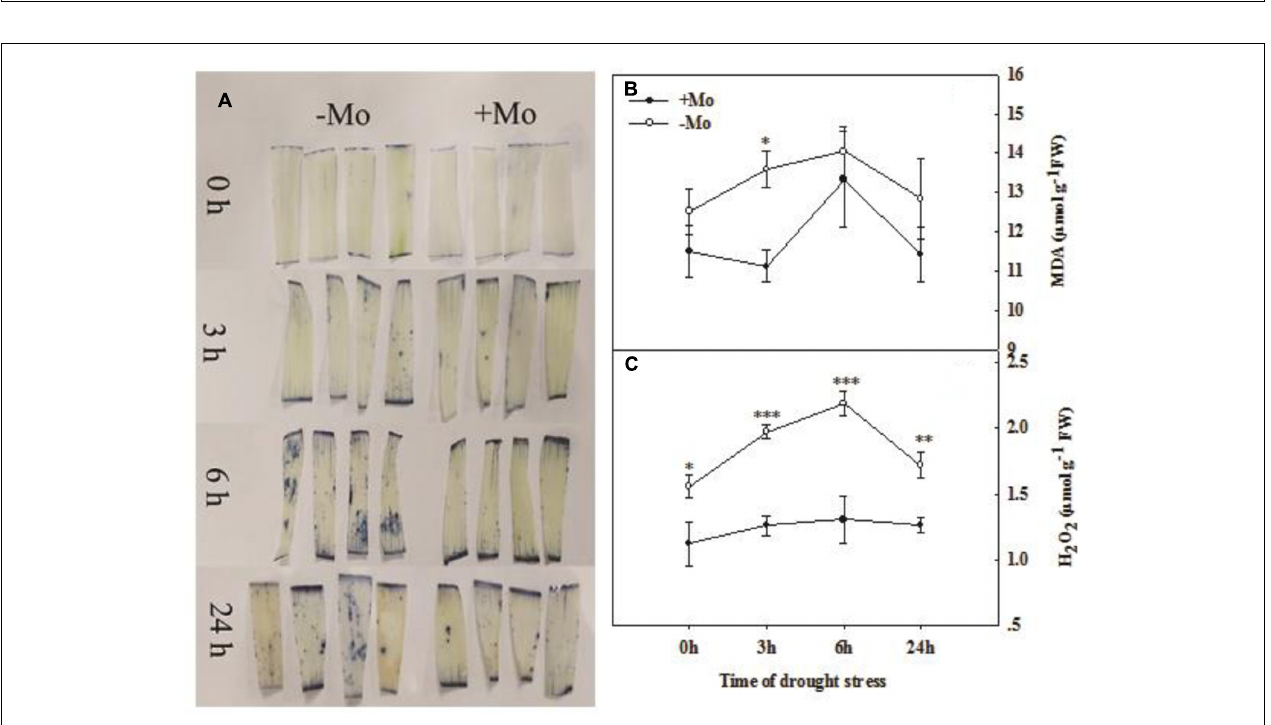
FIGURE 3 | Effects of molybdenum (Mo) application on superoxide anion (O 2 − ; A ), malondialdehyde (MDA; B ), and hydrogen peroxide (H 2 O 2 ; C ) in wheat leaves under polyethylene glycol 6000-simulated drought stress (PSD). –Mo and +Mo treatments represent wheat grown in modified Hoagland solution with 0 and 1 µ M Mo. 0, 3, 6, and 24 h represent 0, 3, 6, and 24 h of polyethylene glycol 6000 (PEG) stress, respectively. Asterisk ( ∗ ) indicates significant difference between –Mo and +Mo treatments by ANOVA followed by Duncan-test multiple comparisons ( ∗ P < 0.05, ∗∗ P < 0.01, ∗∗∗ P < 0.001, n = 4).